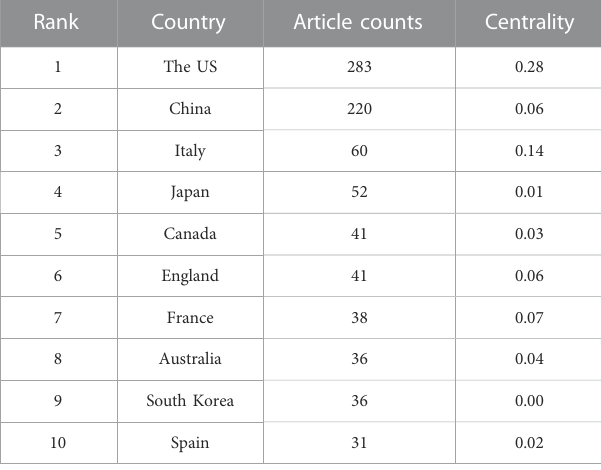
TABLE 1A The top 10 countries with the highest number of published articles.